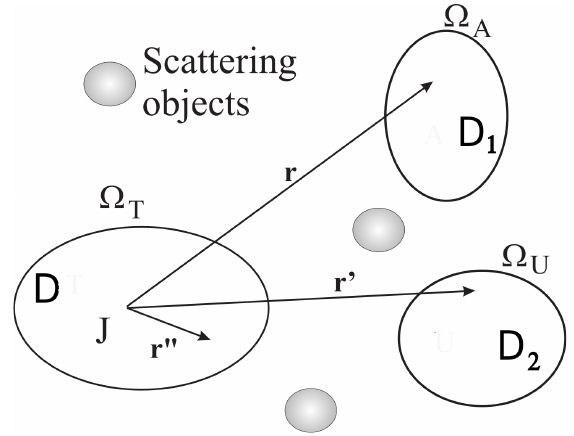
Figure 1. Geometry of the problem; D = Alice’s antenna domain; D 1 = Bob’s antenna domain; D 2 = Eve’s antenna